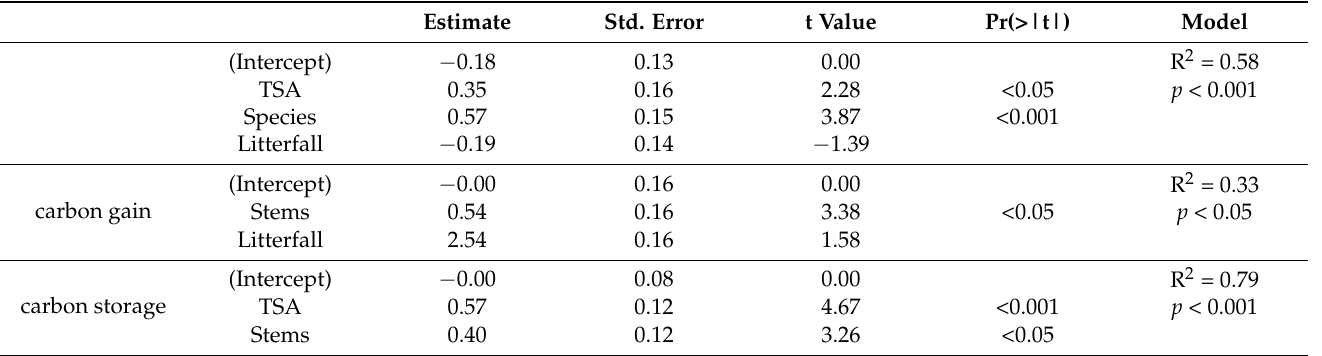
Table A1. Linear models to evaluate the effects of time since abandonment (TSA), number of species and stems per plot and average annual litterfall per plot on carbon storage, carbon losses, and carbon